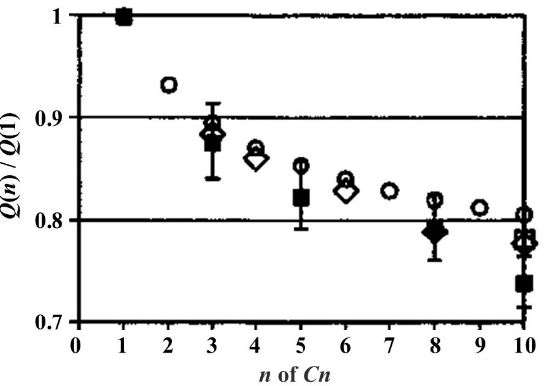
Figure 6. Foil-thickness dependence of from carbon foil, with the experimental data [13]. ( a ) lines and broken lines refer to linear-chain structure and ring structure [14].